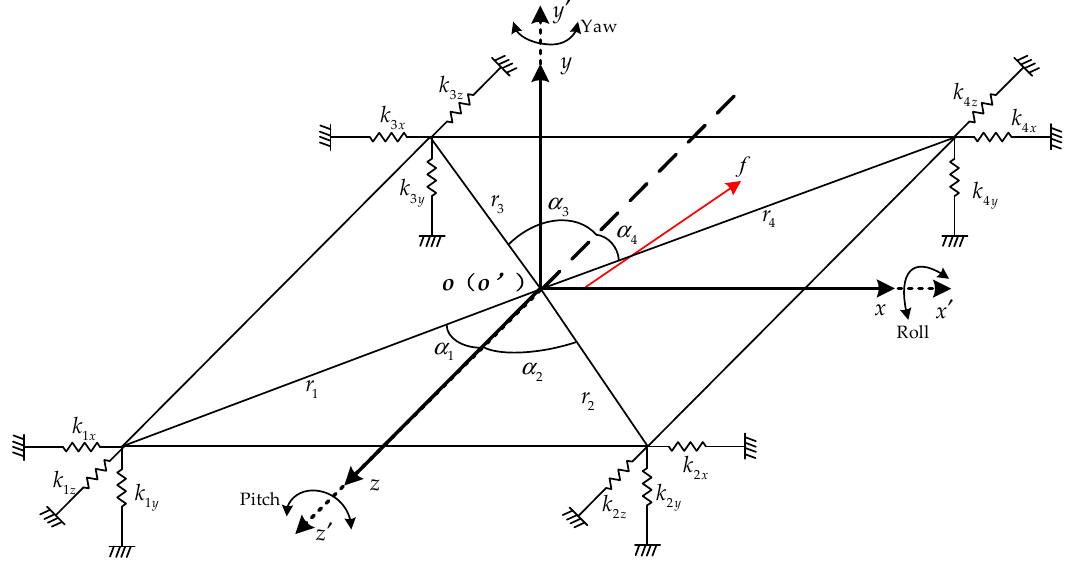
Figure 3. Spatial motion dynamic model of the mining vibrating screen, including three translational degrees of freedom and three rotational degrees of freedom.